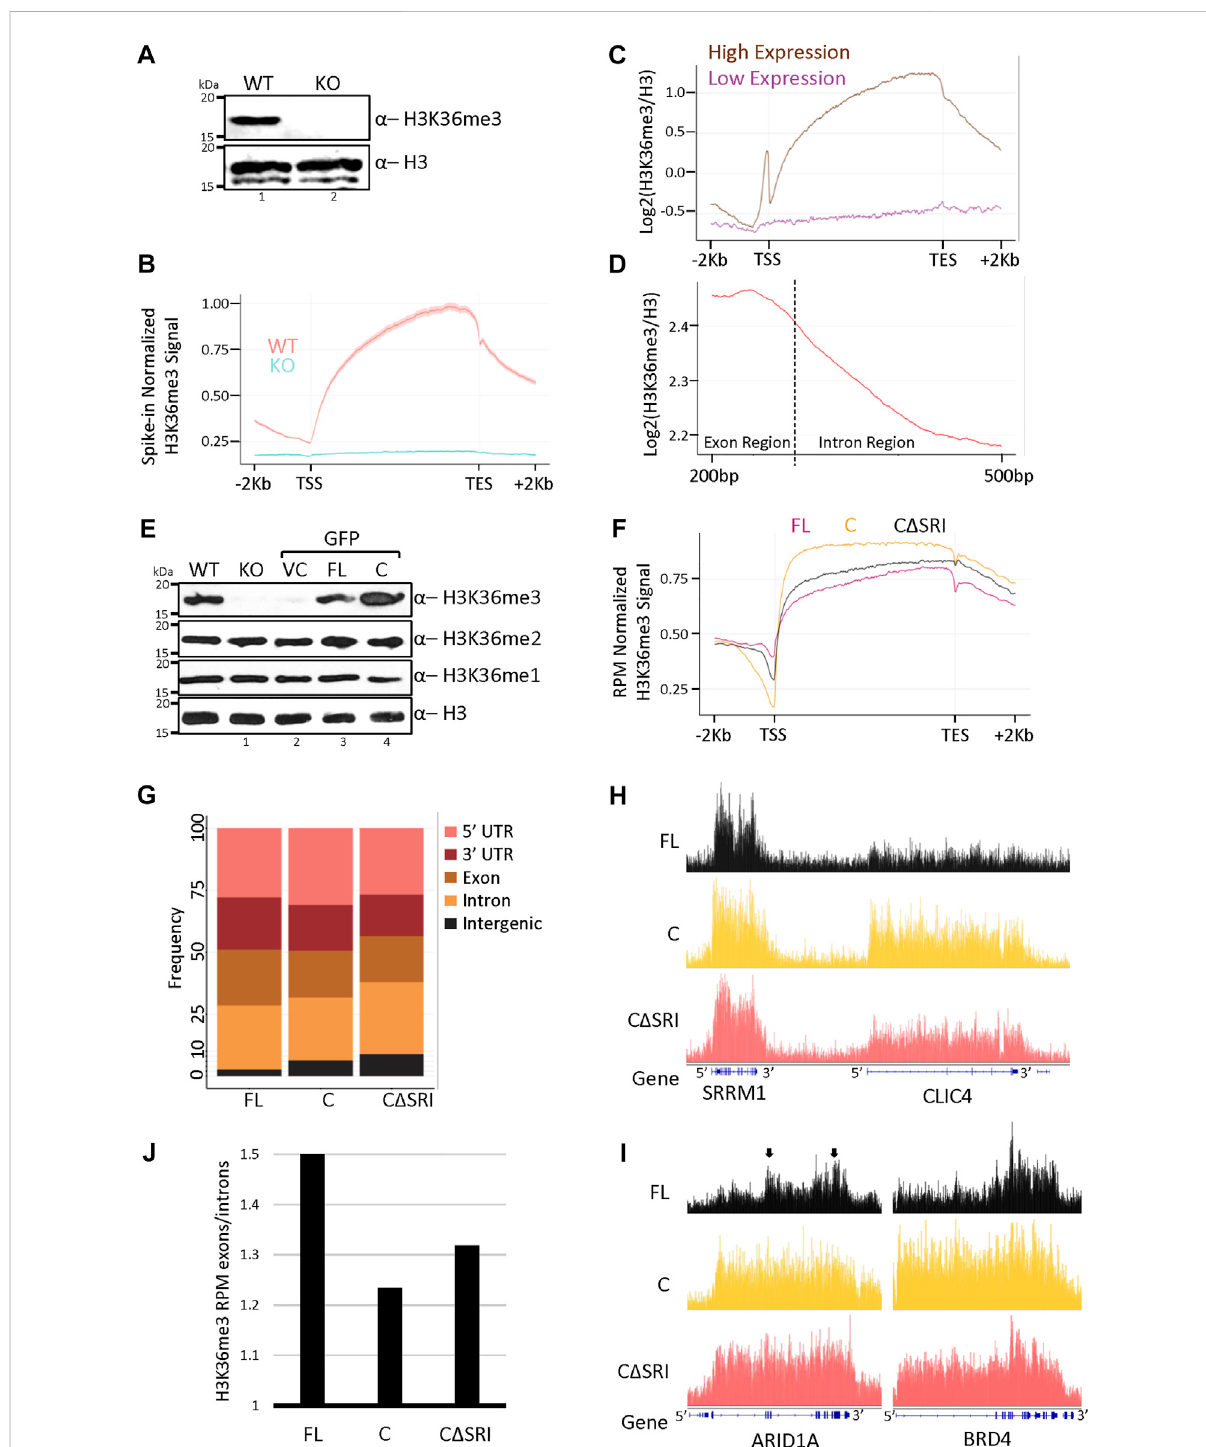
FIGURE 1 IncreasedSETD2abundanceleadstoanon-canonicalH3K36me3deposition. (A,E) Westernblotofwhole-celllysatesprobedwiththedepicted antibodies. setd2 Δ 293T (KO) cells were transfected with GFP-vector control (VC), SETD2 full-length (FL), or SETD2 C (C) and lysates were prepared 72 hpost-transfection.WTiswildtype. (B – D,F) Metageneplots depicting thenormalizeddistribution ofH3K36me3inWT,KO( setd2 Δ 293T),andKO cellsexpressingSETD2constructs. (G) Histogramdepicting thedistributionofH3K36me3.Thedottedlinein (D) isrepresentingtheintron/exon junction. In our analysis, the average length for the exon was 326 base pairs (median was 139 base pairs), and the average length for the intron was around 4600 base pairs (median around 1080 base pairs). Hence, a shorter exon region length and longer intron region length is depicted in the H3K36me3 metagene plot with exon/intron junction regions. (H,I) Genome browser tracks depicting the peaks of H3K36me3. The blue solid blocks ontheX-axisdenotetheexons. The arrowshighlightthegreater enrichmentofH3K36me3 over exon-rich regions ofARID1A. (J) Bar graph showing the H3K36me3 enrichment over exons as compared to